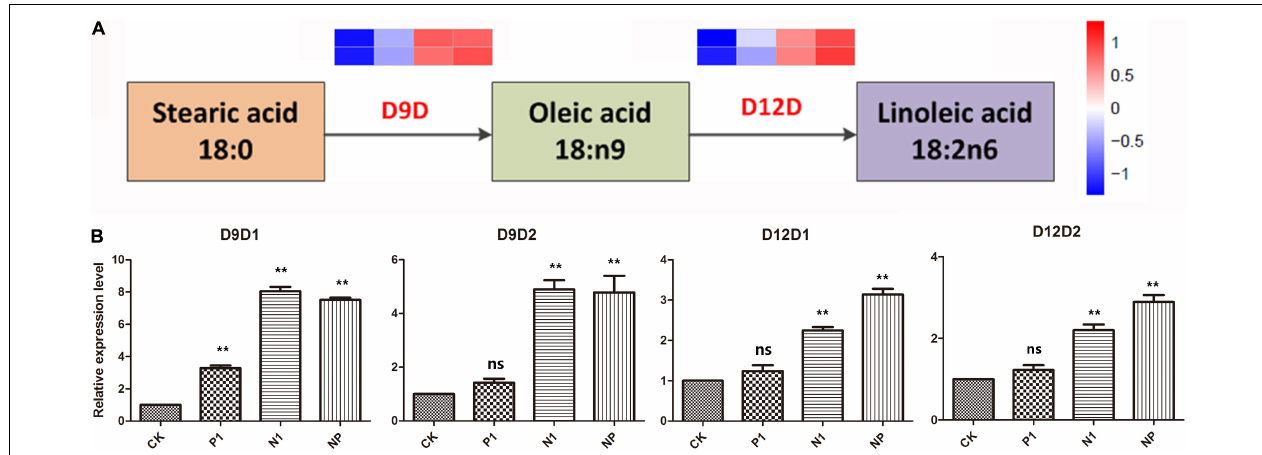
FIGURE 5 | DEGs are involved in the linoleic acid biosynthesis pathways and the changes of C18 fatty acid in response to different nitrogen and phosphorus limitation. (A) The expression pattern of DEGs involved in the linoleic acid biosynthesis pathways. (B) The relative expression levels of four genes in response to different nitrogen and phosphorus limitation. The bars represent the average ( ± SE) of biological repeats. Asterisks indicate statistically significant differences between groups (Student’s t -test): ** p < 0.01, ns: no significant difference. CK: the control; P1: the single P limitation (P-); N1: the single N limitation (N-); NP: N deep limitation and P limitation (N-